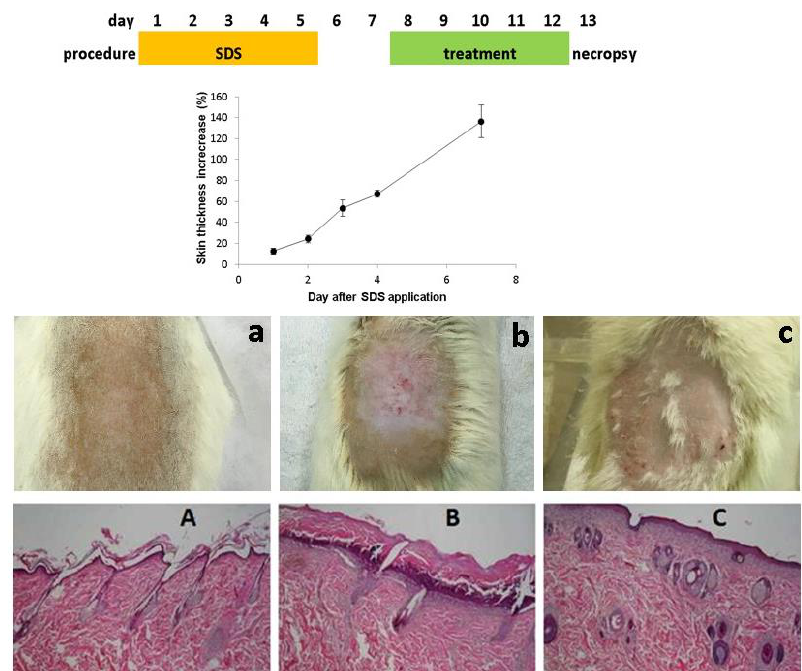
Figure 6. Top: timeline representation of the in vivo model; in the middle: skin thickness (%) during the application of the SDS gel. Bottom: photographs of: ( a ) the skin from naïve control rat skin; ( b ) rat skin treated topically with SDS gel; ( c ) rat skin treated topically with SDS gel followed by topical application of AP-NLC; representative microphotographs of skin stained with haematoxylin and eosin (200× magnification) from: ( A ) naïve control rat skin; ( B ) rat skin treated topically with SDS gel; ( C ) rat skin treated topically with SDS gel followed by topical application of AP-NLC.